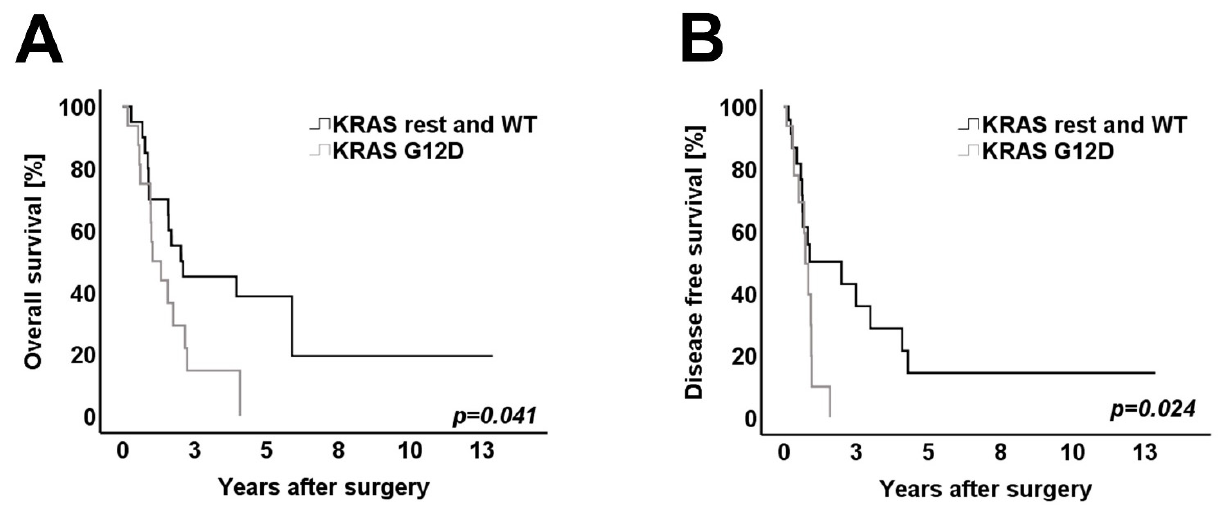
Figure 3. Kaplan–Meier survival curves for: ( A ) Overall survival of patients with a KRAS G12D mutation and patients with other KRAS mutations and WT ( n = 39). ( B ) Disease-free survival of patients with KRAS G12D mutation and patients with other KRAS mutation and WT ( n = 39). Log- rank test was used to test for significance. p -value < 0.05 indicates significance. Patients with KRAS G12D mutations showed a significantly worse OS and DFS when compared to patients with all other KRAS mutations or WT.